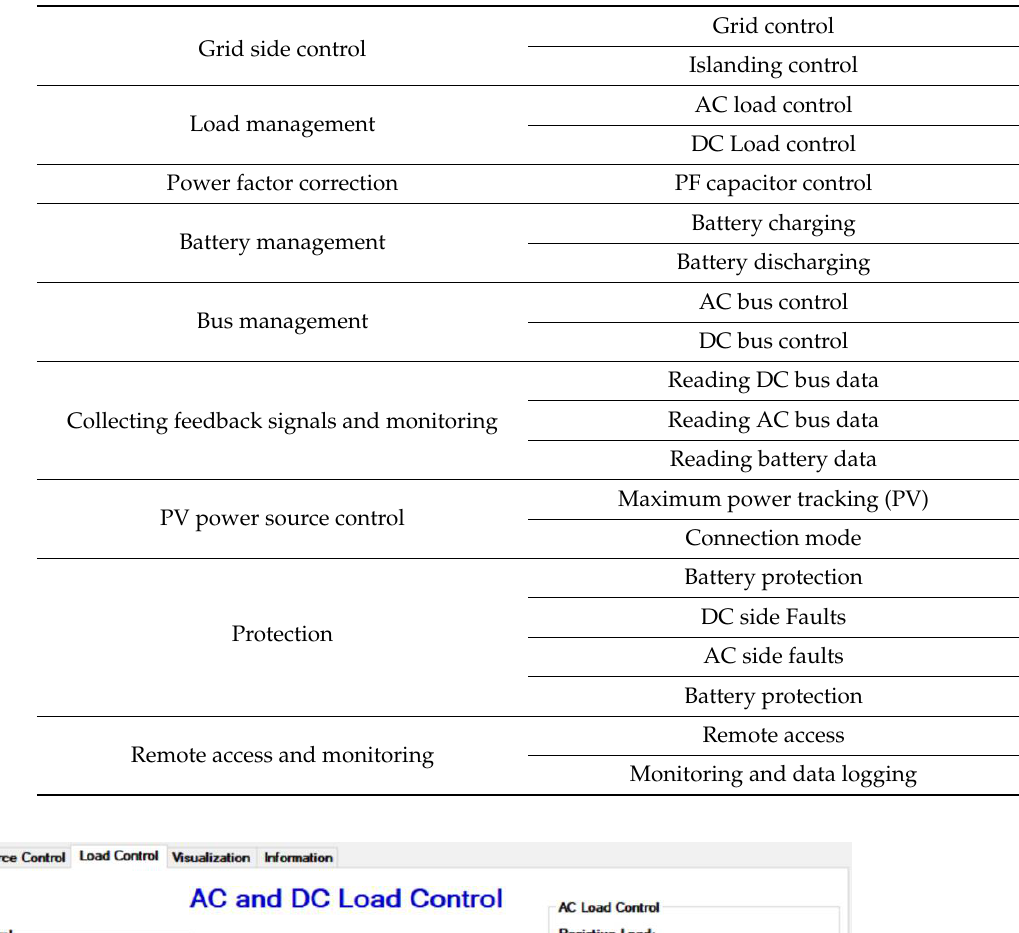
Table 6. Testing and validation parameters.